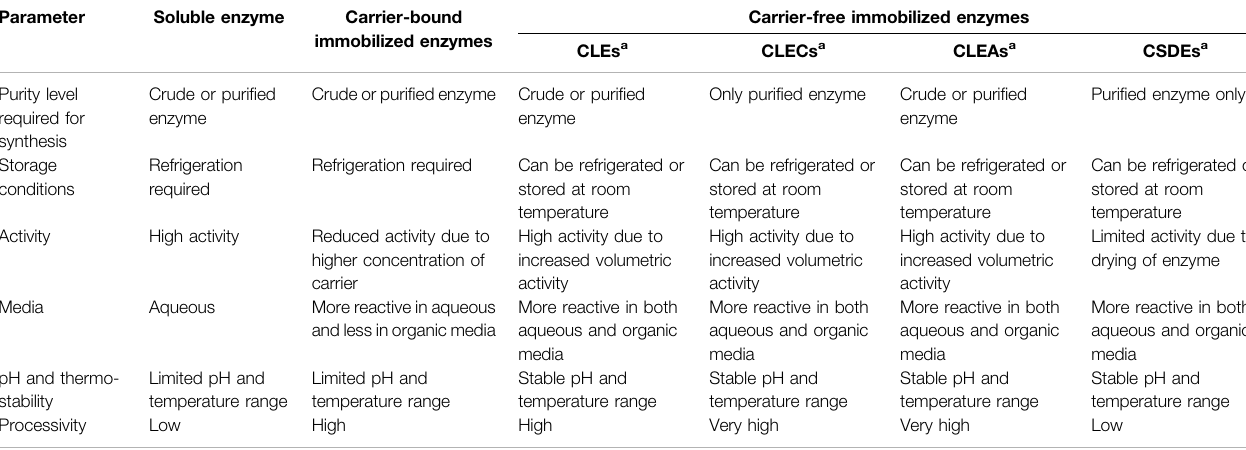
TABLE 1| Comparison ofdifferent propertiesofsoluble, carrier-bound immobilized, and carrier-free immobilized enzymes(Jegan Royand EmiliaAbraham, 2004; Cuiet al., 2014; Vob ě rková et al., 2018). Parameter